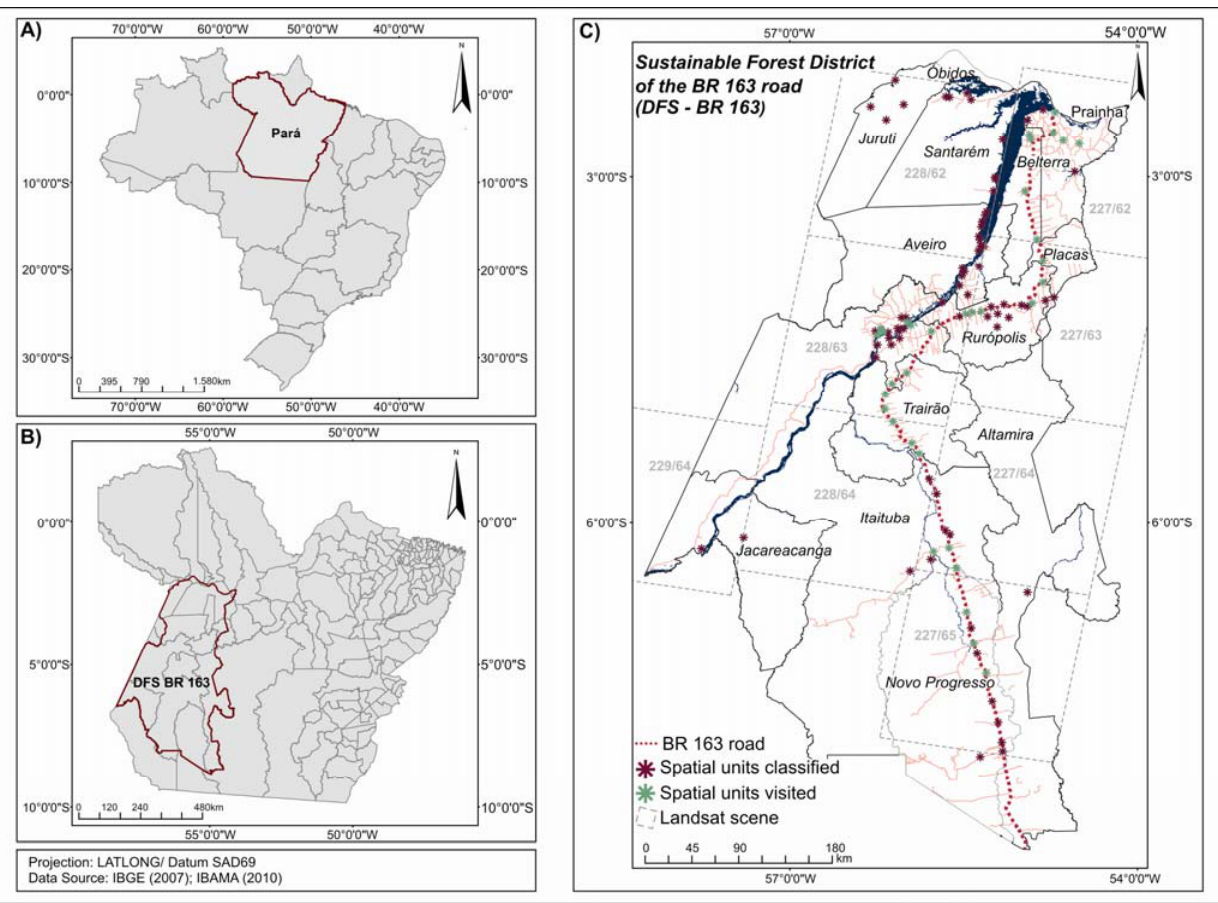
Figure 1. Study site: ( A ) Pará state in Brazil; ( B ) the Sustainable Forest District of the BR-163 highway (SFD-BR163); ( C ) political limits of the municipalities and the spatial units location in the SFD-BR163, with Landsat TM images